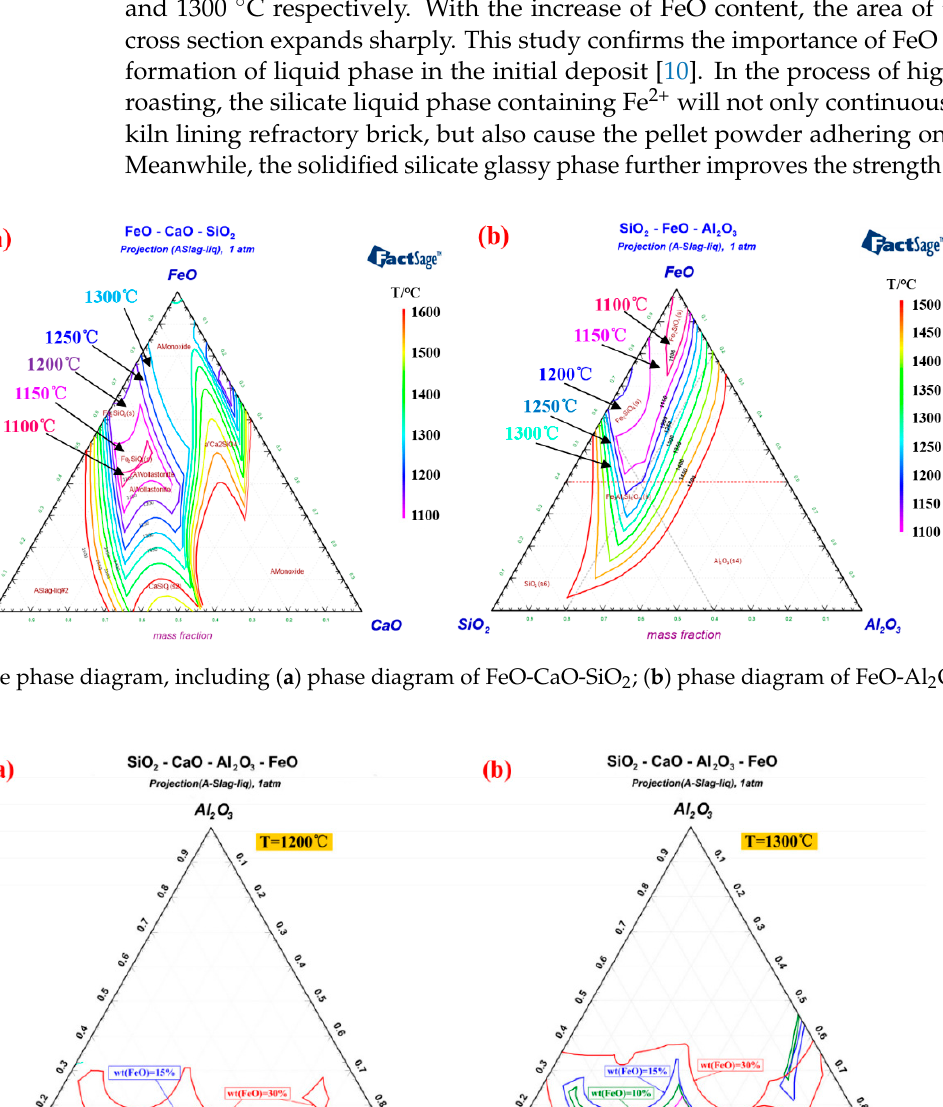
Figure 9. The phase diagram, including ( a ) phase diagram of FeO-CaO-SiO 2 ; ( b ) phase diagram of